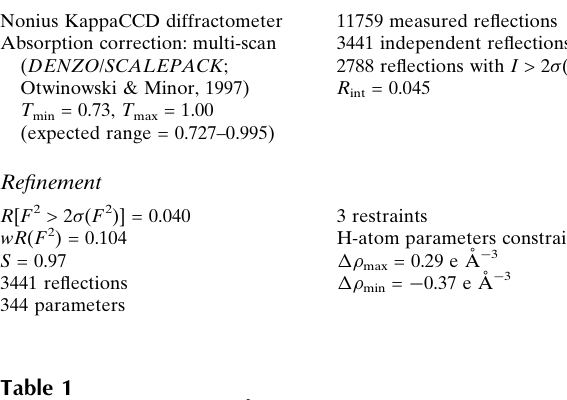
Hydrogen-bond geometry (A˚ , (cid:2)